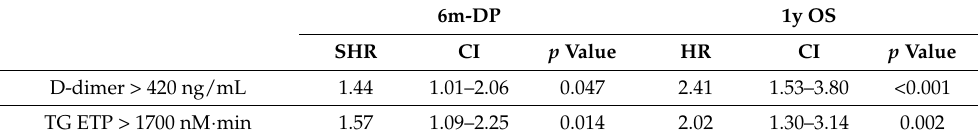
Table 4. Proportional hazard regression analysis for 6m-DR and death during first year from